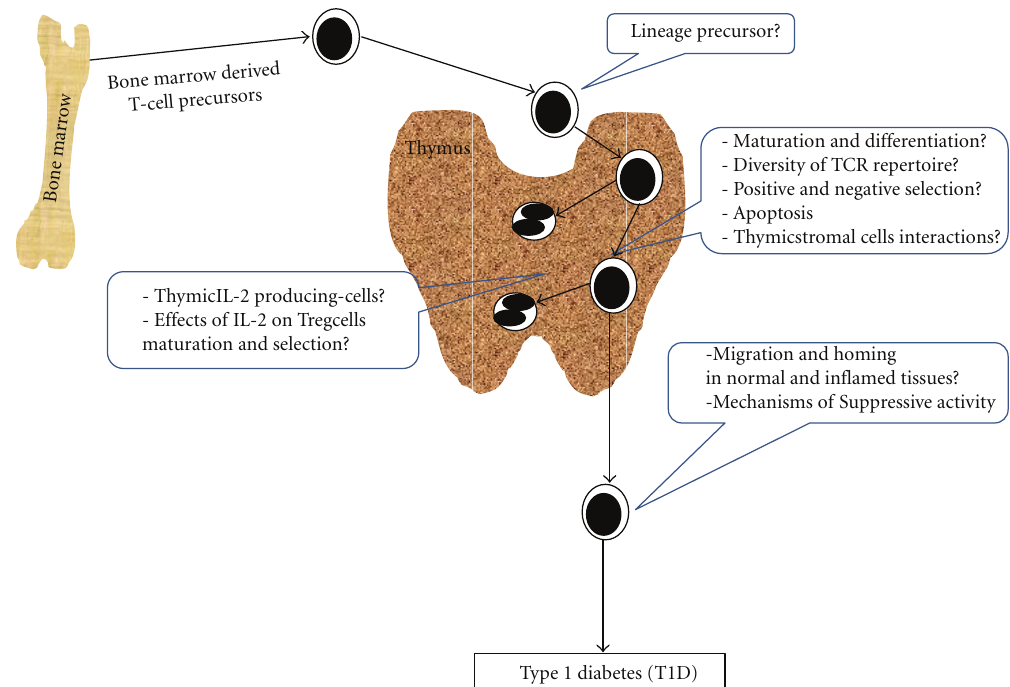
Figure 2: Fundamental questions about naturally occurring CD4 + CD25 + regulatory T cells development and function.